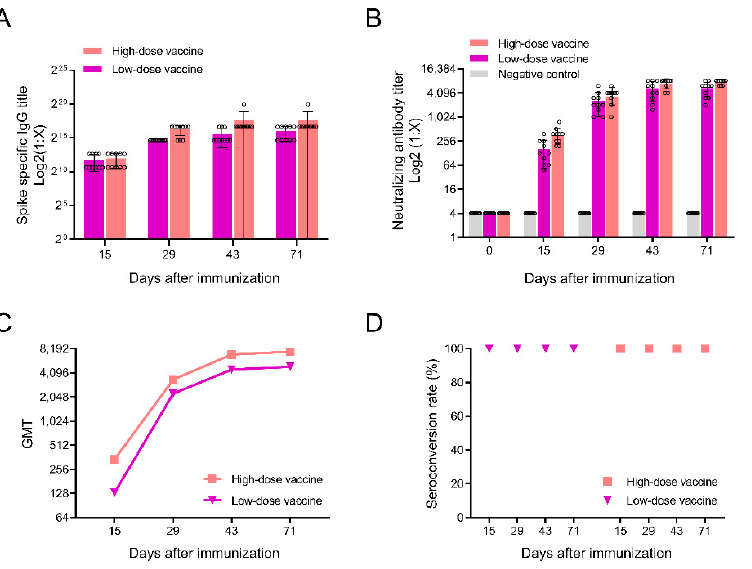
Figure 2. The antibody responses of immune serum to SARS ‐ CoV ‐ 2. ( A ) Results of the specific IgG antibodies to SARS ‐ CoV ‐ 2 spike protein in serum at different time points detected by ELISA, each circle represents a sample; ( B ) results of the levels of neutralizing antibodies against SARS ‐ CoV ‐ 2 in serum, each circle represents a sample; ( C ) measurement of the GMTs of neutralizing antibody; ( D ) neutralizing antibody seroconversion rates in the serum of immunized rats were measured. The data are presented as means ± s.d ( n = 10).